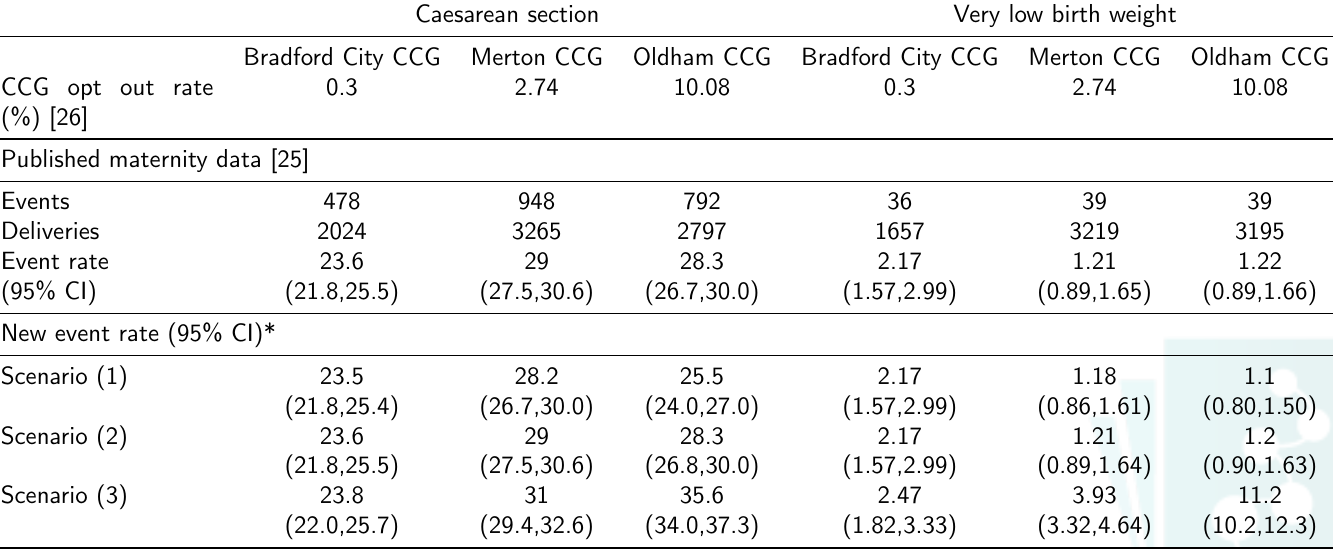
Table 1: Published and simulated number of events, patients and event rates, by indicator and CCG. Data from the National Child and Maternal Health Intelligence Network [25] and NHS Digital